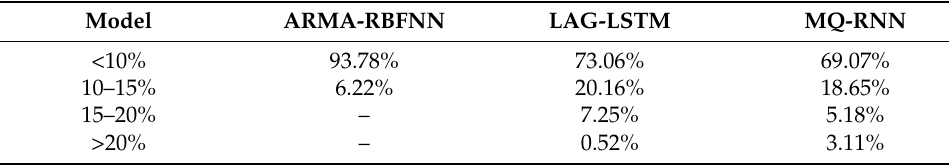
Figure 12. MAPE comparative analysis results. Table 4. Comparison prediction error of MAPE.